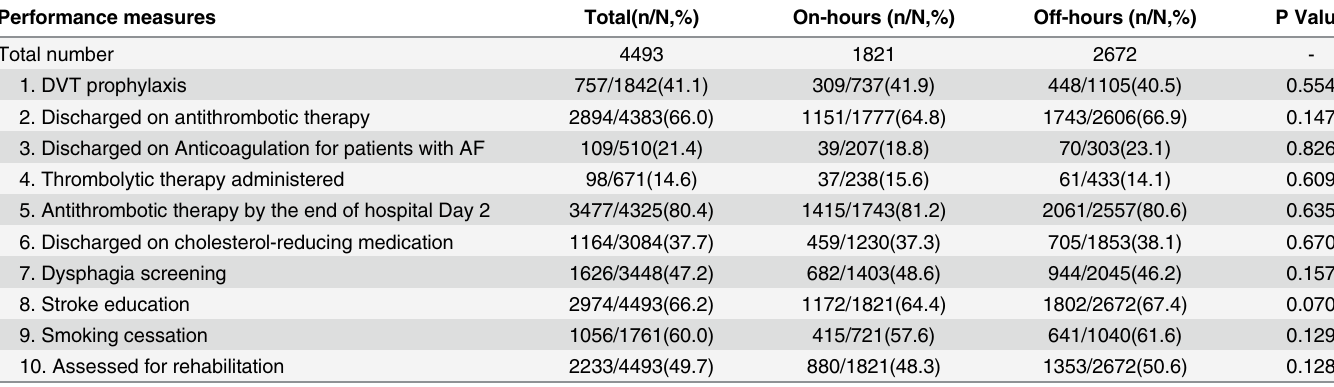
Table 2. Quality of Care Indicators and Off-hour vs On-hour Presentation after Ischemic Stroke. Performance measures